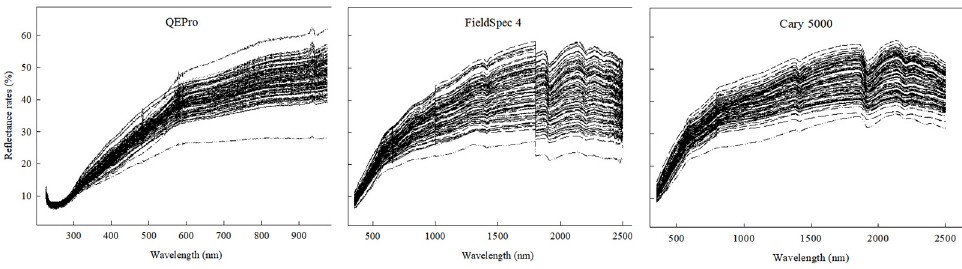
Figure 3. The reflectance spectra of sediments in Huanghai and Bohai Sea of China by different spectrometers.